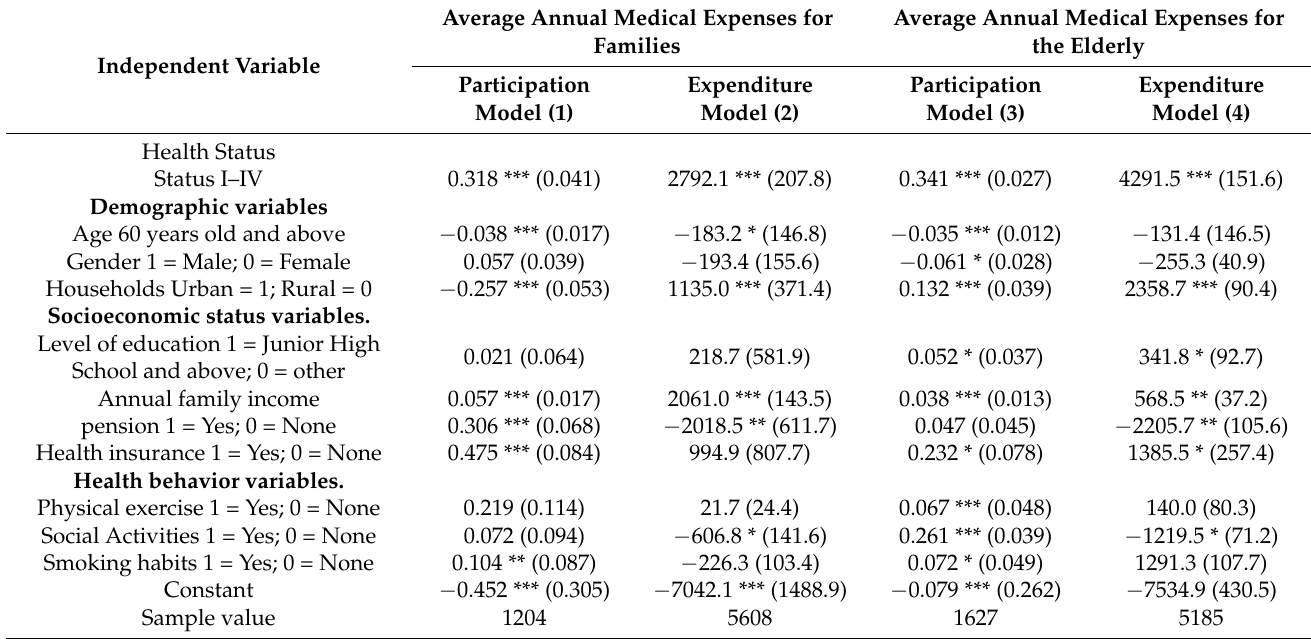
Table 4. Estimated relationship between health status and medical